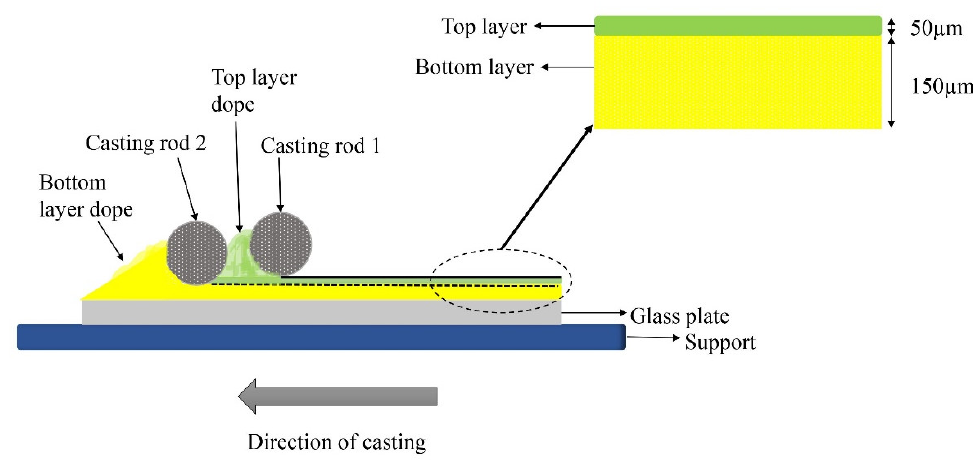
Figure 12. Illustration of the co-casting technique.